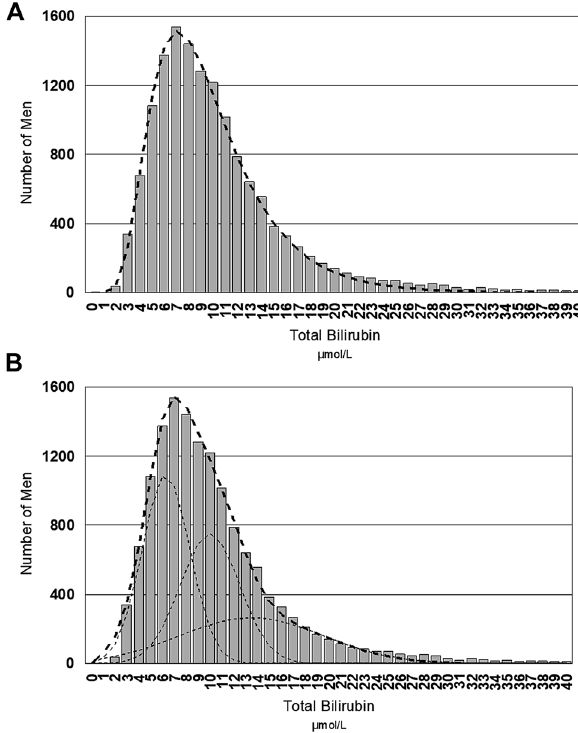
Figure 6: Distribution of serum bilirubin values in young men between 20 and 29 years of age. Panel(A)showsthelogGaussiansolutiontotheskeweddistribution whilst panel (B) shows three overlapping normal Gaussian populations as the solution to the